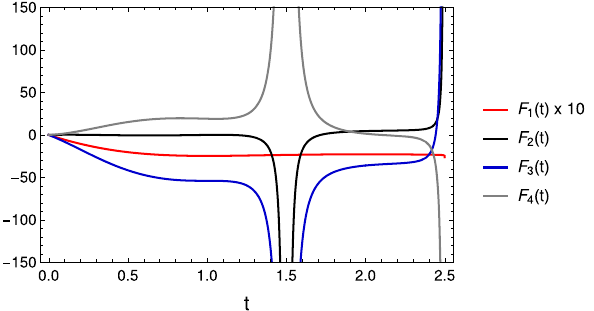
Fig. 7 The functions F 1 , F 2 , F 3 and F 4 given in Eqs. (25), (76),(44),(44),resp. F 1 hasthefirst(logarithmic)singularityat t = 5 / 2, whereas F 2 − 4 show a second-order pole at t = 3 /